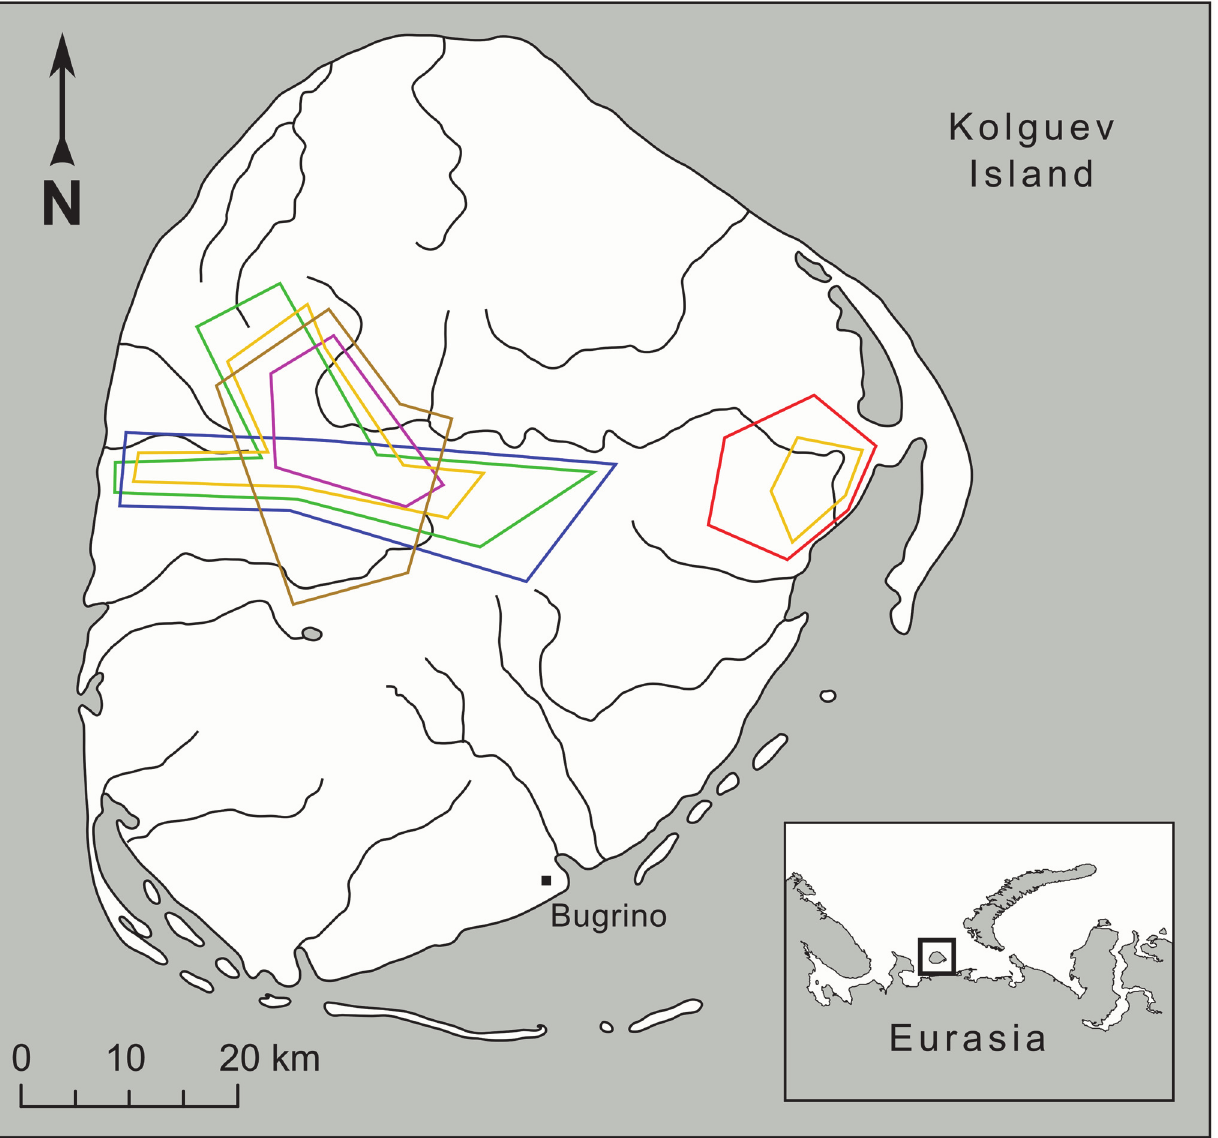
Fig 1. Map of Kolguev Island, Russia. Polygons show the approximate areas surveyed for buzzard nests and fox dens. Red polygon shows the survey area in 2006, green — in 2007, blue — in 2008, purple — in 2011, orange — in 2012 (two polygons), brown — in 2013.